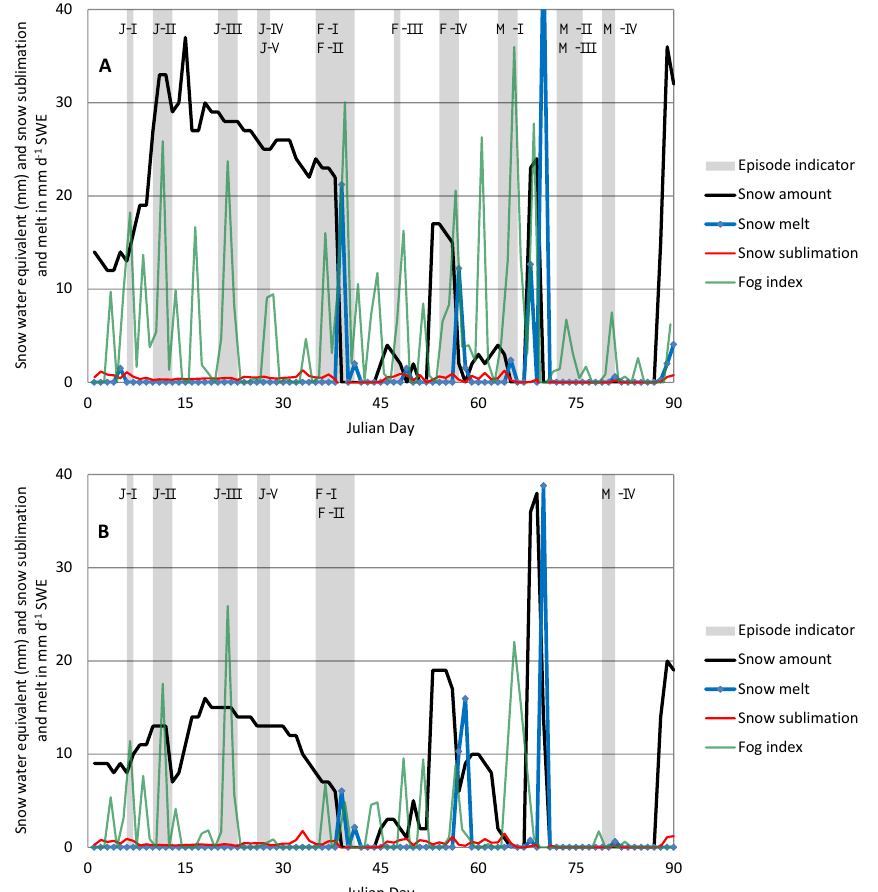
Fig. 11. Time series showing snow cover, snowmelt, snow sublimation, fog, and episodes as a time series for Milwaukee (A) and Mayville (B) . Rain also occurs in this time period but is not shown. All variables are at daily time resolution to match the daily resolution of the SNODAS data. The fog index is calculated from hourly visibility data, and a value at 100% of the y-axis scale would result from 24h of the maximum visibility deficit in the data (16.3km). Only hours with the temperature within 2.5 ◦ C of dew point and wind speed less than 4ms − 1 are considered to have fog in the index calculation.